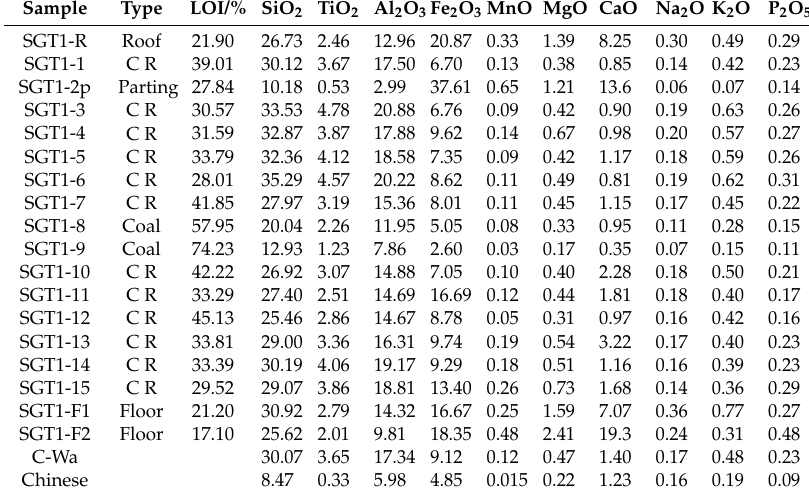
The rows with gray shading are of carbonaceous rock (C R) benches. LOI, loss on ignition; C-Wa, weighted average for coal and carbonaceous rock, based on thickness of bench interval; Chinese coals, date from Dai et al. [11].